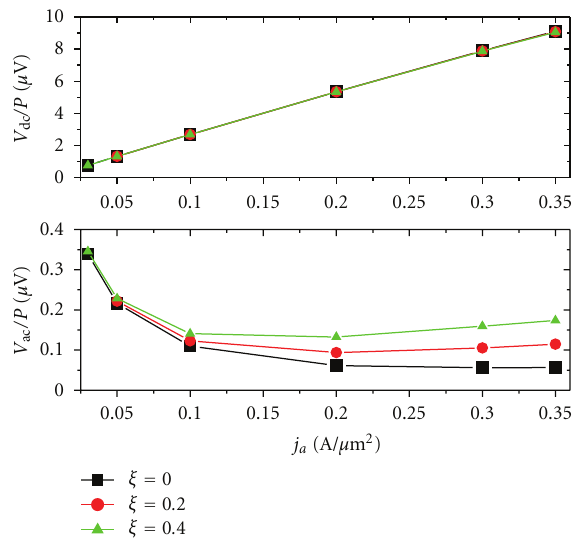
Figure 10: Voltage signal as due to the pinned DW oscillations driven dcs as computed from μM simulations. Static ( V dc ) and oscillating ( V ac ) contributions of the voltage signal V smf ( t ) are depicted in (top) and (bottom), respectively. (from